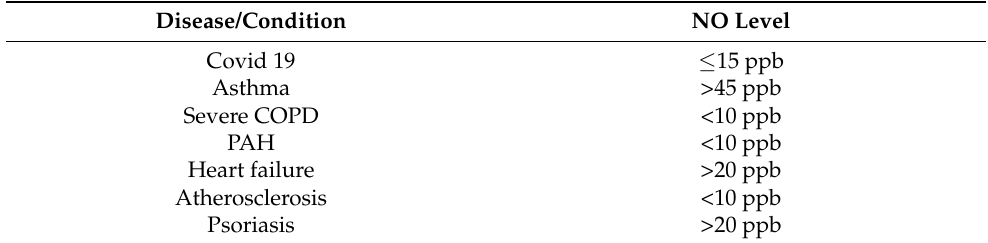
Table 1. NO concentration in exhaled breath for different health